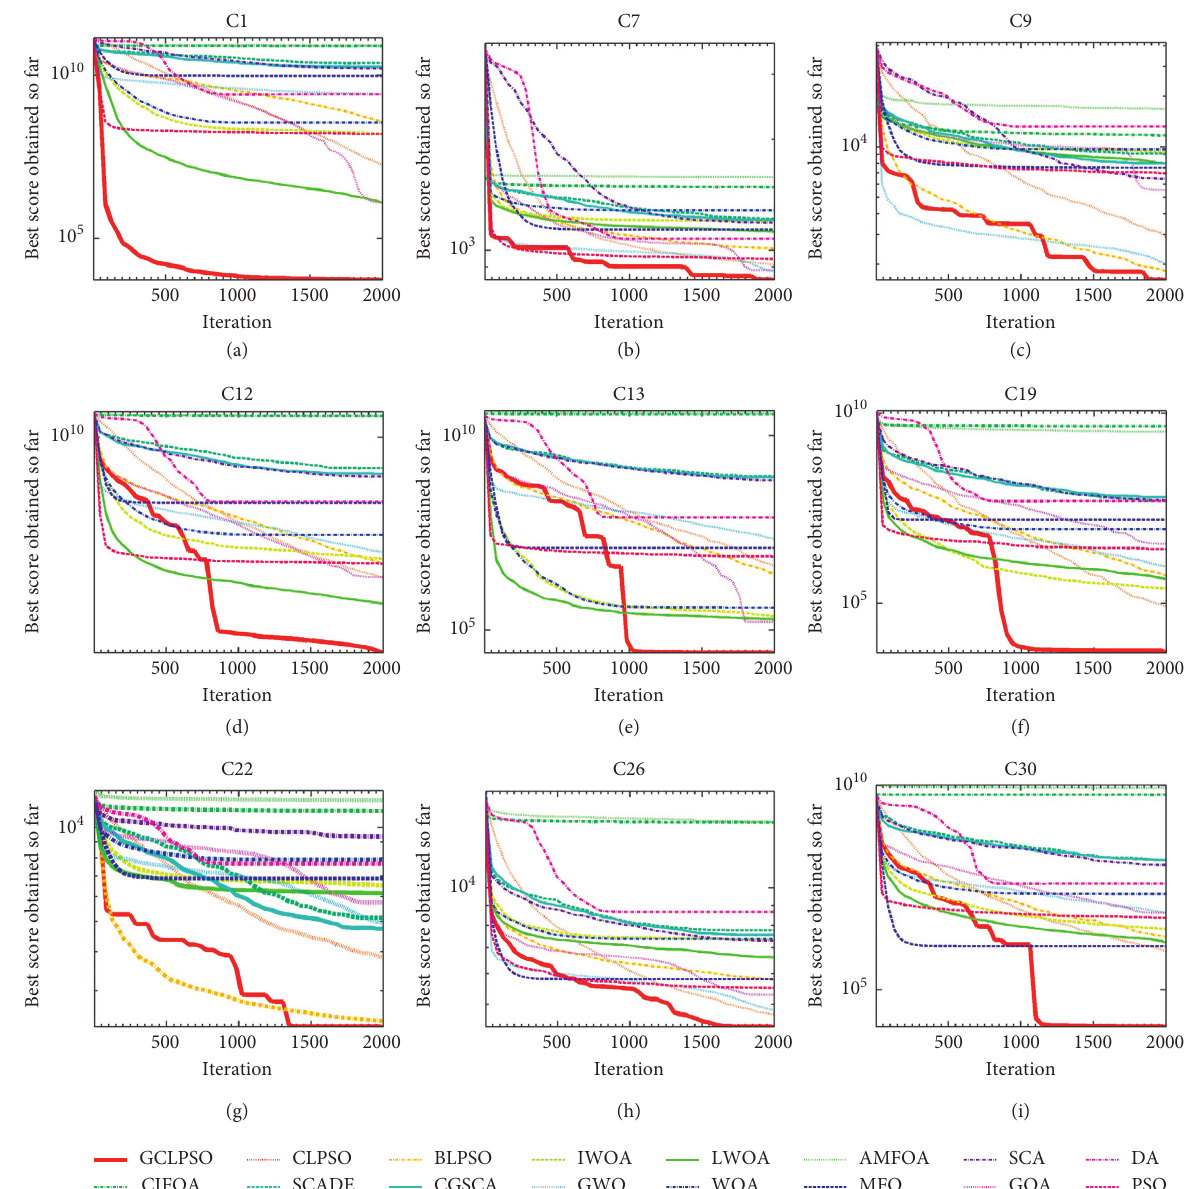
Figure 2: Convergence trend of the GCLPSO and other